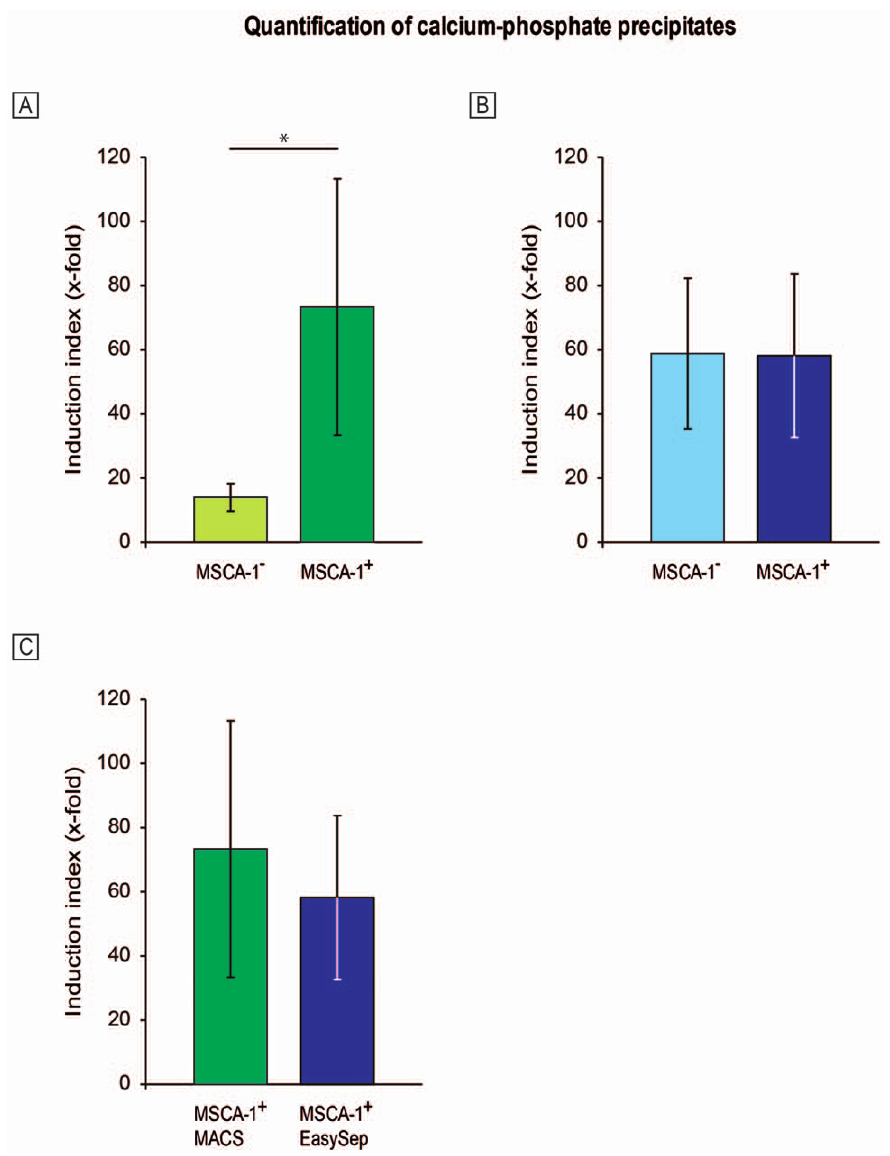
Figure 3. Quantification of the mineralization capacity of the MACS- (bright and dark green columns) and EasySep- (bright and dark blue columns) separated cell fractions. After Alizarin Red staining and subsequent dissolving of the dye from the monolayers, calcium phosphate precipitates were photometrically quantitated (n=13 for each separation method). The increase in amounts of calcium-phosphate precipitates compared with the untreated controls (induction index, x-fold) is illustrated. A 5-fold higher amount of precipitates was detected in the MACS-separated MSCA-1 + compared with the MSCA-1 2 cells (p , 0.05) (A). In contrast, EasySep-separated cell fractions did not significantly differ concerning their mineralization capacity (B). The direct comparison of the positive fractions separated by both methods showed no significant differences, as shown in part C of the figure.